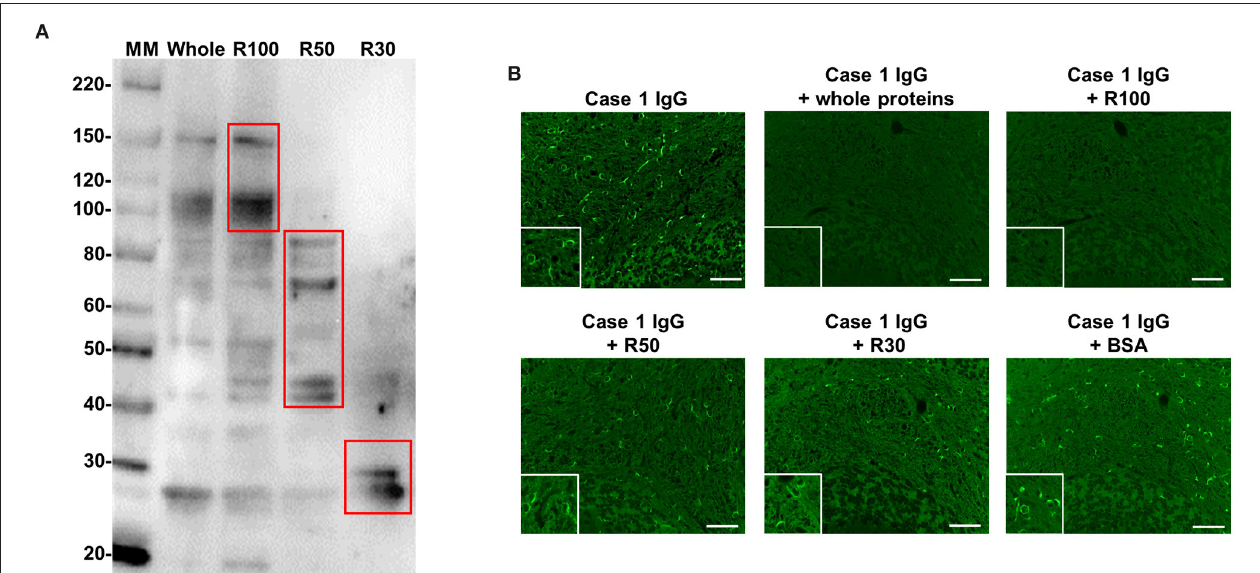
FIGURE 5 | WB with IgG from Case 1 using whole protein and three different MW fractions (R100, R50, and R30) of mouse cerebellum and immunoadsorption assay by IFA. (A) WB with IgG from Case 1 in Figure 1 using whole protein and three different MW fractions (R100, R50, and R30) of mouse cerebellum. Whole protein and R100 fraction of mouse cerebellum included proteins of approximately 110 and 150 kDa, which were recognized by Case 1 IgG, whereas R50 and R30 fractions of mouse cerebellum did not include proteins with a MW larger than 100 kDa, which were recognized by Case 1 IgG. (B) Immunoadsorption assay by IFA. The immunostaining (green) of oligodendrocytes by IgG from Case 1 was removed by preincubation with whole protein and the R100 fraction of mouse cerebellum, whereas preincubation with R50, R30, or BSA did not remove the immunostaining (green) of oligodendrocytes by IgG from Case 1. Scale bar = 50 µ m. IFA, immunofluorescence assay; IgG, immunoglobulin G; MM, molecular marker; MW, molecular weight; R, residue; WB, western blotting.